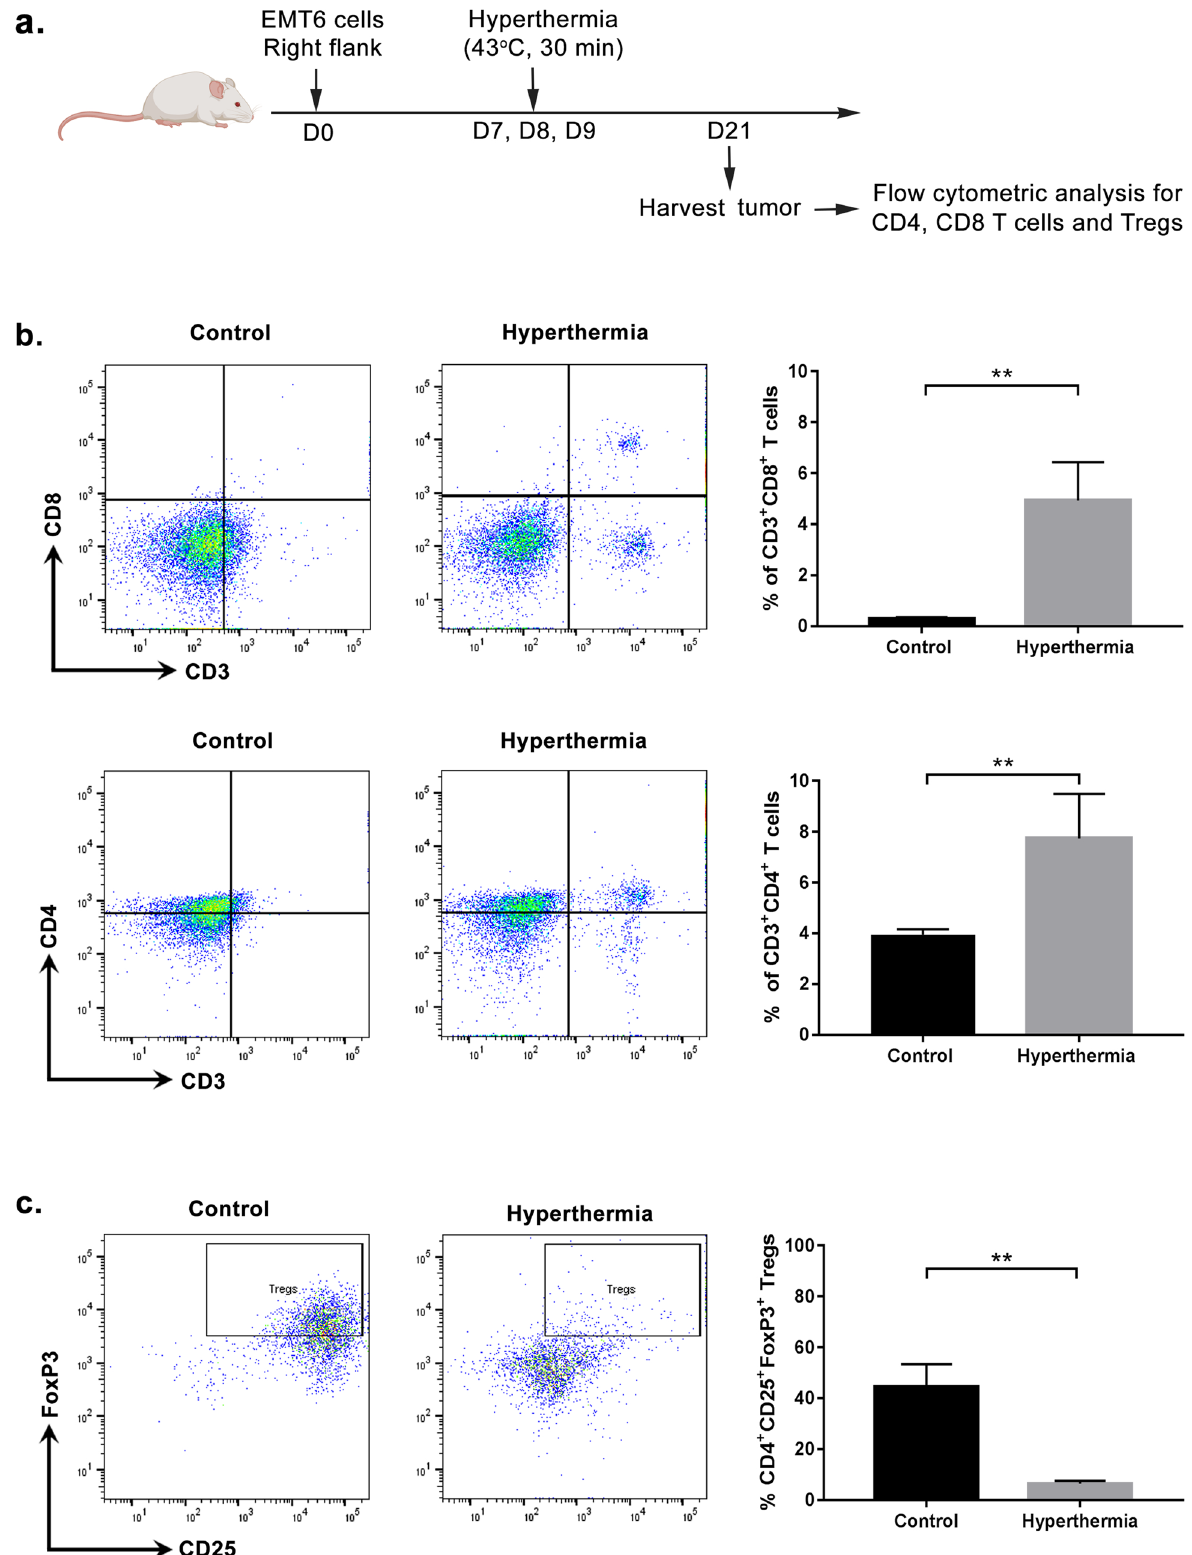
Figure 6. Influence of local hyperthermia by NIR on T cells. Mice were sacrificed 14 days after treatment to evaluate T cells infiltrated at tumor site. Single cells suspension was analyzed by flow cytometric analysis. ( a ) Schematic timecourse to study the tumor-infiltrated T cells. ( b ) Representative dot plot showing population of CD4 and CD8 T cells infiltrated in tumor. Graph showing percentage of CD3 + CD8 + and CD3 + CD4 + T cells (± mean). ( c ) Representative dot plot showing population of Tregs infiltrated in tumor. Gated CD4 + cells were measured for co-expression of CD25 and FoxP3. Graph showing the percentage of CD4 + CD25 + FoxP3 + cells (± mean). n = 5 per group. ns- P > 0.05, ** P < 0.005 (Mann–Whitney